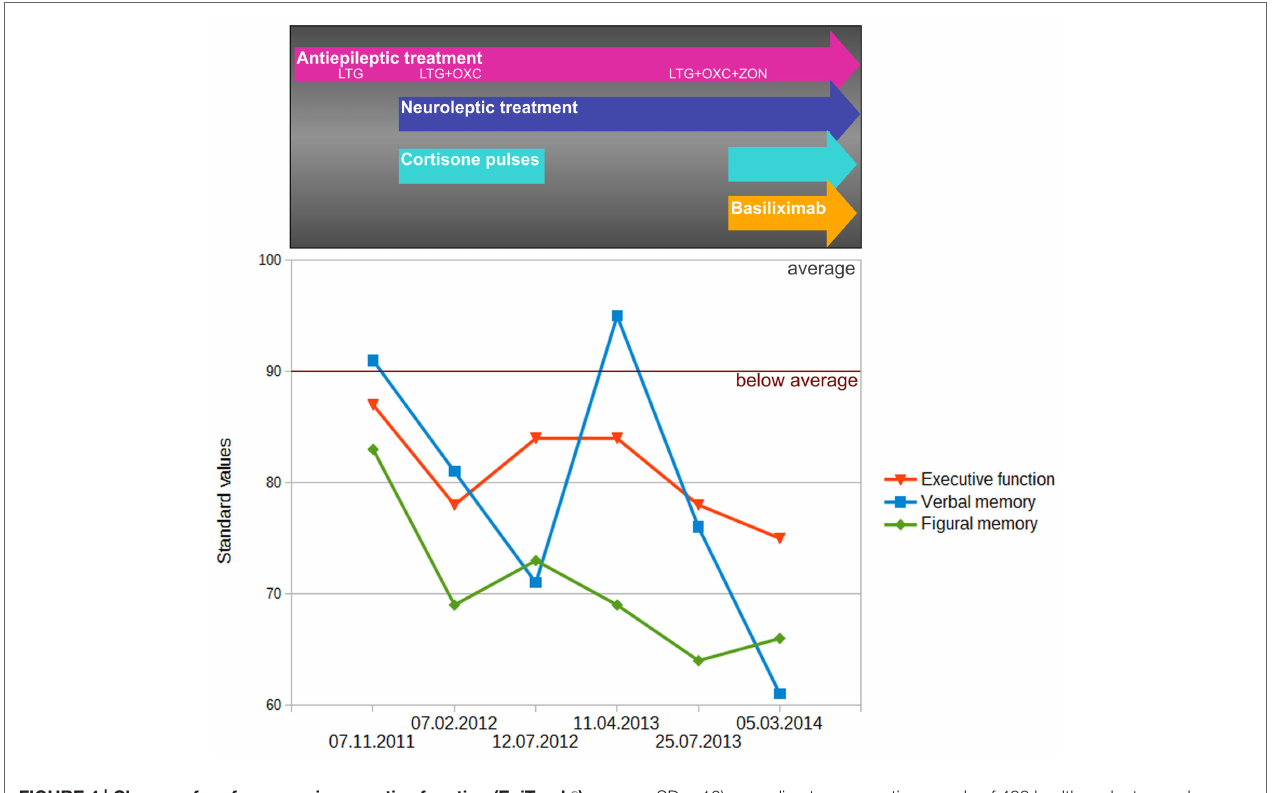
FiGuRe 4 | Change of performance in executive function (epitrack ® ) as well as verbal (VlMt delayed free recall after 30 min) and figural (dCs-R learning performance across five trials) memory performance . Memory performance was standardized (standard values; mean = 100,